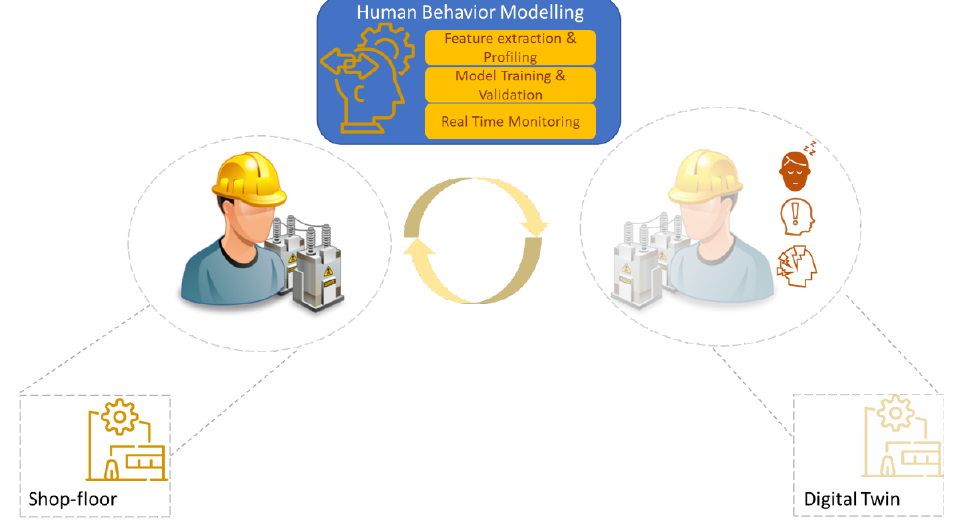
Figure 3. Human Behavior Modeling in the Digital Twin.